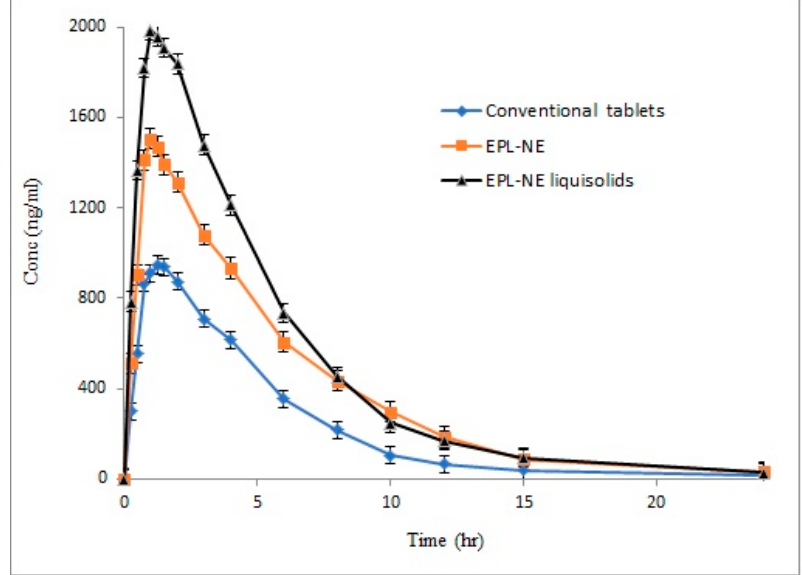
Figure 5. Mean plasma concentration time curves of EPL from different tested forms after administration to rabbits.